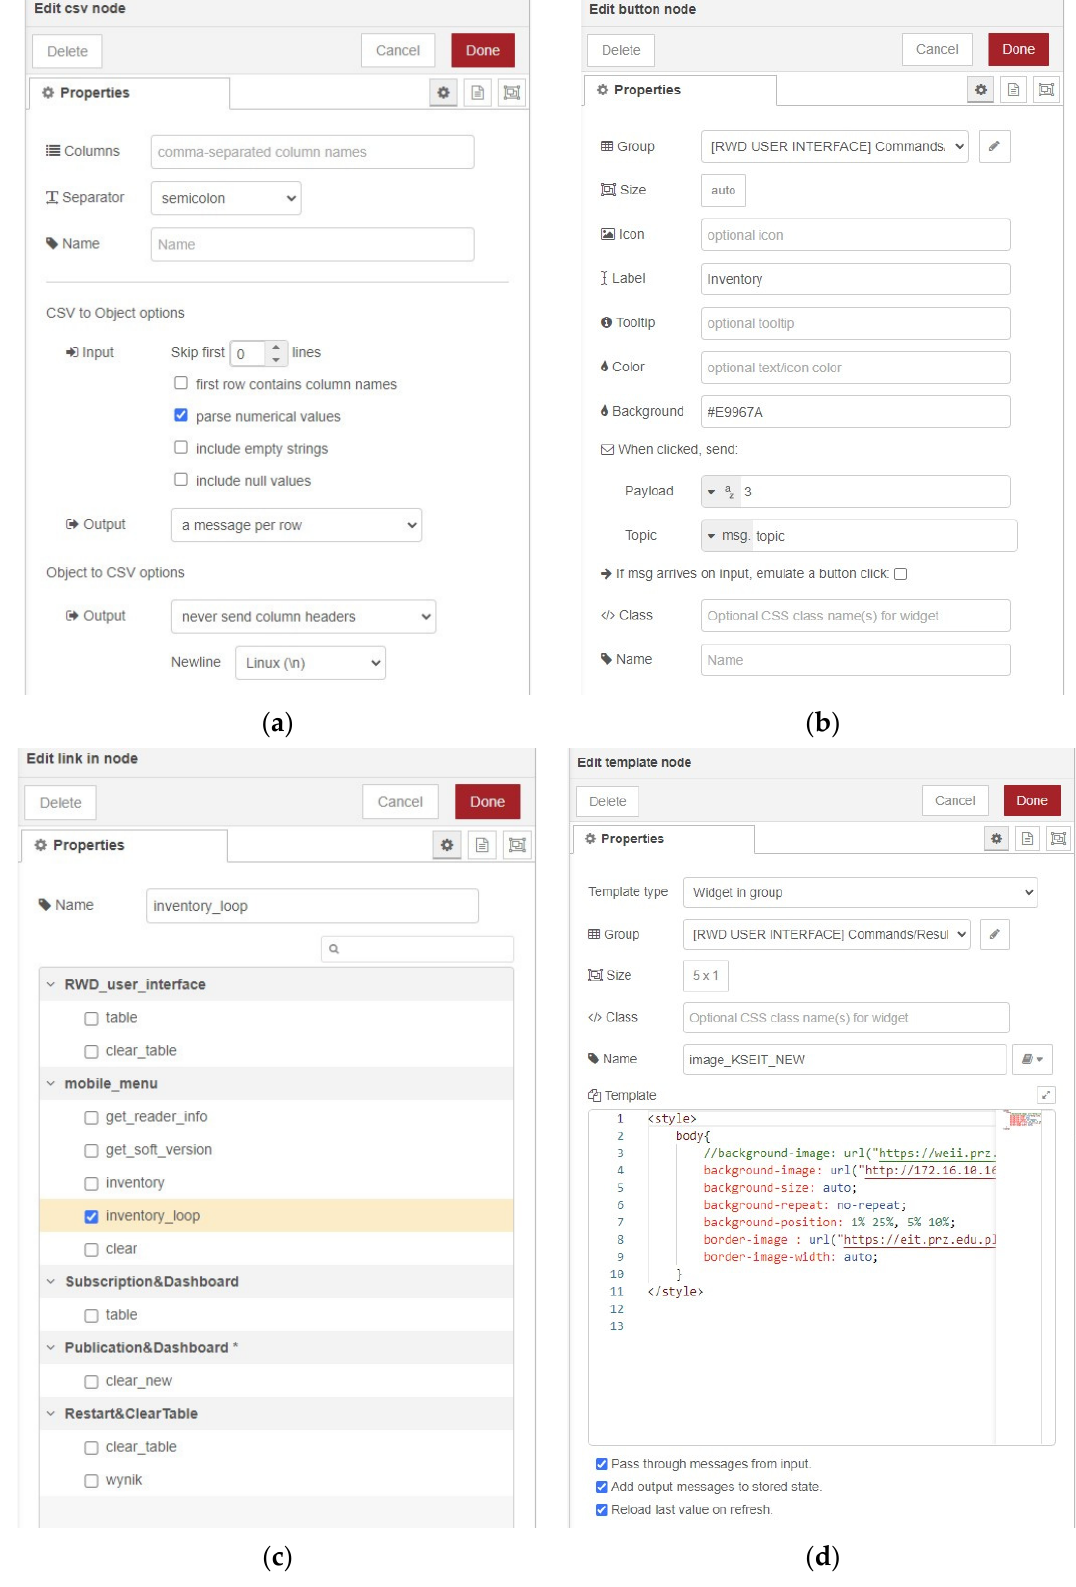
Figure 4. Designing in Node-Red—exemplary objects: ( a ) Options of CSV objects; ( b ) Button appearance settings; ( c ) Button function assignments; ( d ) Designer procedure.